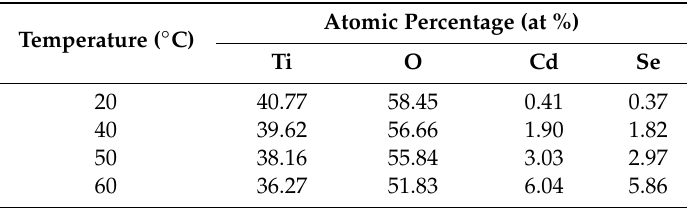
Table 1. An average at % of CdSe–TiO 2 nanotube thin films deposited at di ff erent chemical bath temperatures, obtained by energy dispersive X-ray spectroscopy (EDX) analysis.